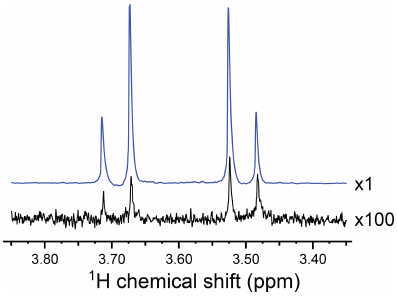
Figure 2. Partial 1 H NMR spectra of the reaction products at a res- onance frequency of 400.0MHz and temperature of 333K, showing the signals from the CH 2 group of I . The hyperpolarized spectrum (blue) was acquired in a gem -PHIP experiment using the pulse se- quence in Fig. 3a, with the intervals τ 1 = 90s and τ 2 = 90s. The spectrum in black was obtained by waiting 90s after the conclu- sion of the experiment and taking the Fourier transform of the NMR signal induced by a single π/ 2 pulse. The spectrum shows an AB peak pattern, with intensity distortions from residual hyperpolariza- tion. The AB spectrum is consistent with a chemical shift difference of (cid:49)δ = 0 . 197ppm and a two-bond J coupling of | 2 J | = 16 . 8Hz. The signal enhancement factor in the gem -PHIP experiment is esti- mated to be ∼ 300, which corresponds to a 1 H polarization level of ∼ 0 .